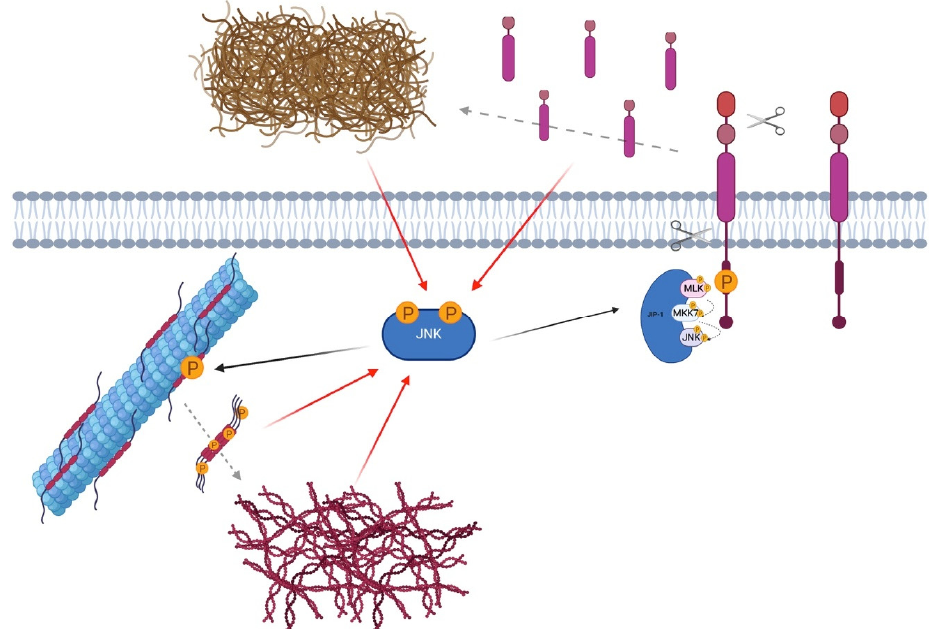
Figure 5. The key role of JNK in Alzheimer’s disease. Activation of JNK induces phosphorylation of the amyloid precursor protein (APP) at the Thr668 site, promoting the amyloidogenic proteolytic cleavage and the production of A β -toxic fragments in brain parenchyma. JIP-1, by linking the APP’s cytoplasmic tail, facilitates its phosphorylation by JNK. JNK also contributes to Tau hyper-phosphorylation and consequently to the formation of neurofibrillary tangles.